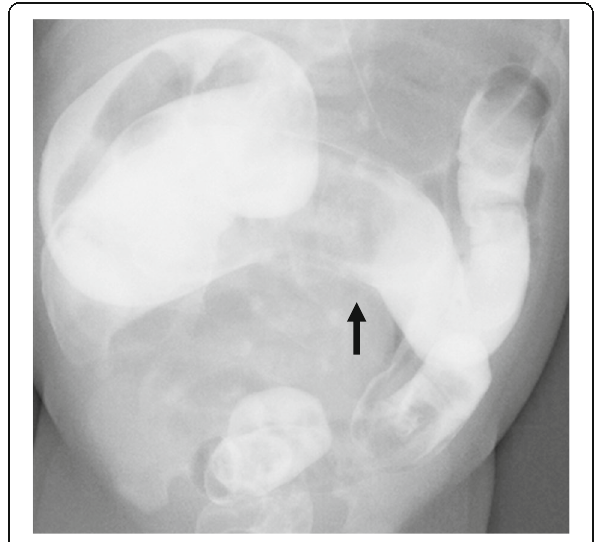
Fig. 1 Gastrografin contrast enema: caliber change in the transverse colon (arrow)